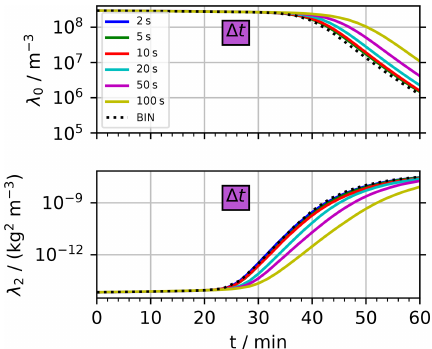
Figure 4. BoxModelEmul set-up: temporal evolution of column- averaged moments λ 0 and λ 2 over 1h for various time steps (cid:49)t (see inserted legend for (cid:49)t values) for the regular AON version. All other parameters take the default values as given in the caption of Fig.